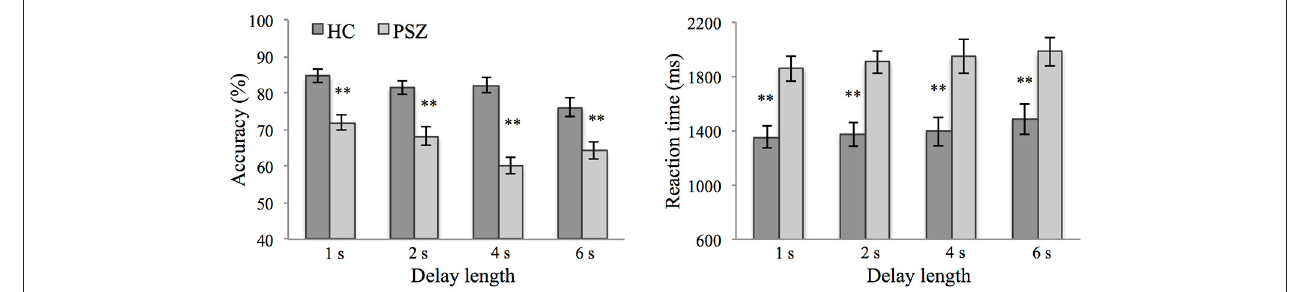
FIGURE 2 | WM accuracy and reaction times at different delay lengths in patients with schizophrenia (PSZ) and healthy controls (HC). Error bars represent the standard error of the mean. Significant group differences at different delay lengths are marked. **indicates p < 0.01, corrected for multiple comparisons. Error variances were equal across groups for all delay lengths (Levene’s test, p > 0.05).